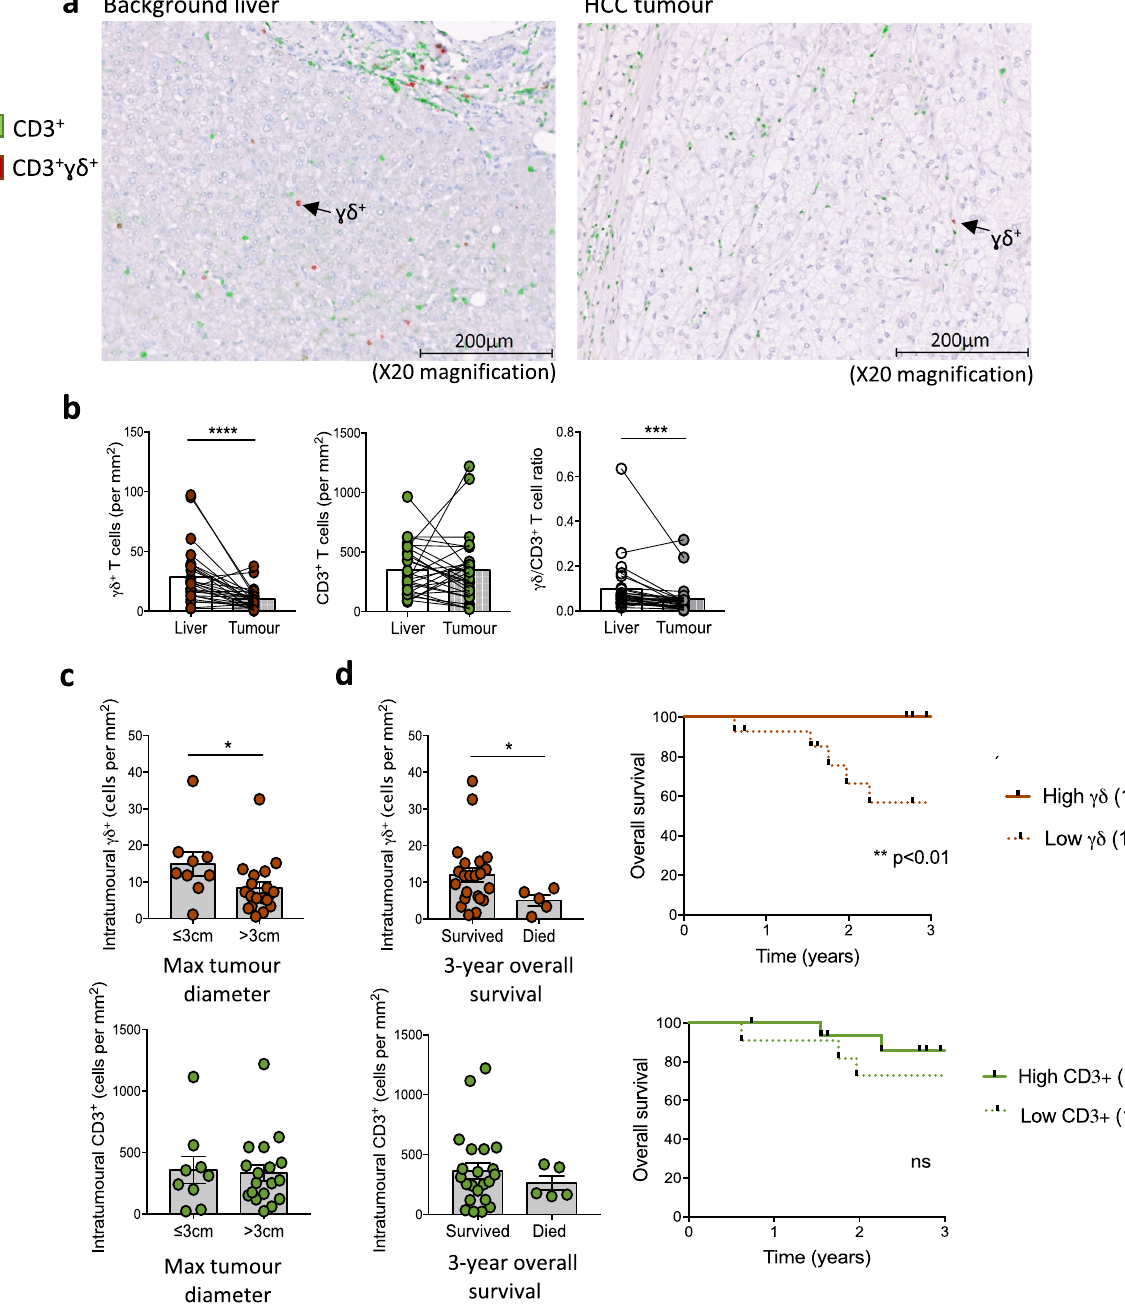
Fig. 4 γδ T-cell counts in HCC are associated with tumour size and patient survival. ( a – d ) Immunohistochemistry staining of paired background liver and tumour tissue obtained from patients with hepatocellular carcinoma (HCC) undergoing surgical resection. Cell counts performed from fi ve randomly selected high-power fi elds (x20 objective magni fi cation) per sample ( n = 28 paired samples). a Representative multispectral analysis with non- γδ CD3 + (green) and γδ + (red) T-cells as pseudo-colourised images in liver and HCC tumoural tissue, replicated across fi ve high-power (x20) fi elds per sample. b Absolute γδ T-cell and non- γδ CD3 + T-cell numbers (calculated per mm 2 ) and γδ /CD3 + T-cell ratio in paired liver and HCC tumours ( n = 28 paired samples; p < 0.0001, p = 0.0006). c Intratumoural γδ T-cell counts and non- γδ CD3 + T-cell counts (per mm 2 ) in small HCC tumours with a maximum diameter of ≤ 3 cm compared to HCC tumours >3 cm in diameter ( n = 28; p = 0.03). d HCC intratumoural γδ T-cell counts and non- γδ CD3 + T-cell counts (per mm 2 ) according to 3-year patient survival outcomes (overall survival data available n = 27, 22/27 survived, 5/27 died; p = 0.048). Kaplan Meier graphs of overall survival (years post resection) split on the median intratumoural γδ T-cell ( p = 0.009) or non- γδ CD3 + T-cell count from 27 HCC tumours. Two-tailed p -values were determined using Wilcoxon matched-pairs signed rank test test ( b ) or Mann – Whitney test ( c , d ), Kaplan Meier graphs with Log-rank test ( d ). Error bars represent mean ± SEM. ns Not signi fi cant; * p < 0.05; ** p < 0.01; *** p < 0.001, **** p <